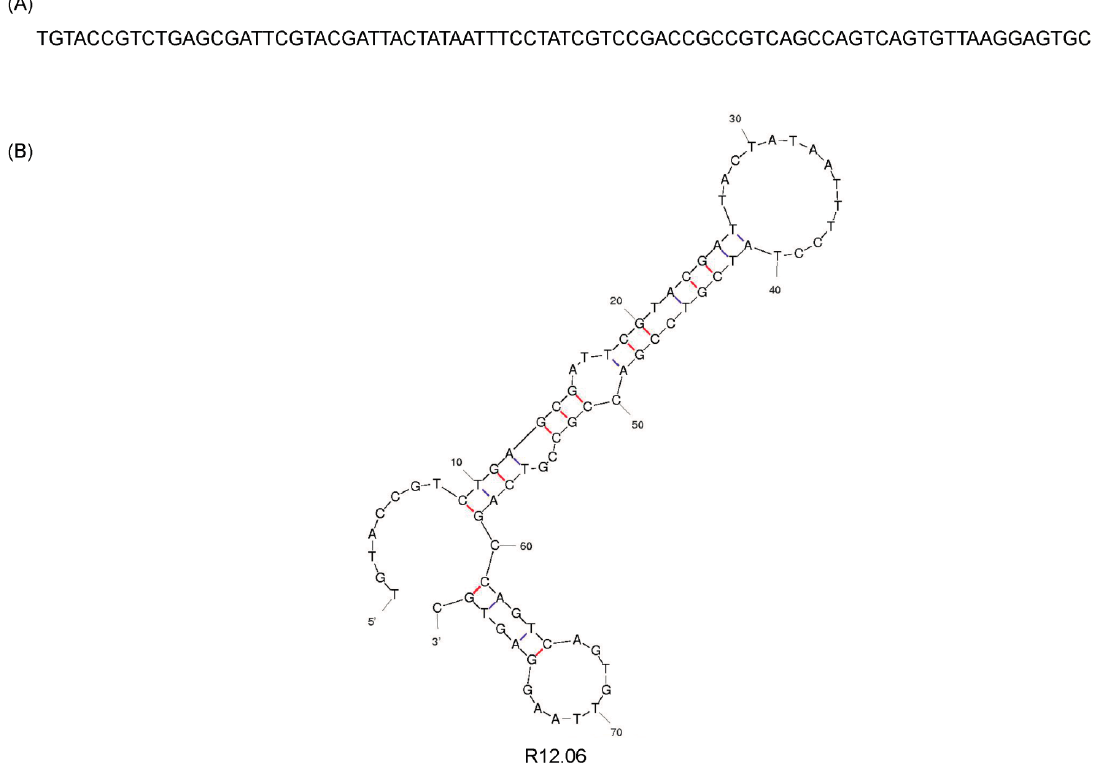
Figure 2. Sequence and secondary structure of R12.06 ssDNA MRE. Hydrogen bonds are indicated in red between GC base pairs and in black between AT base pairs. ( A ) ssDNA sequence of alpha toxin MRE R12.06; and ( B ) Mfold prediction of R12.06 secondary structure